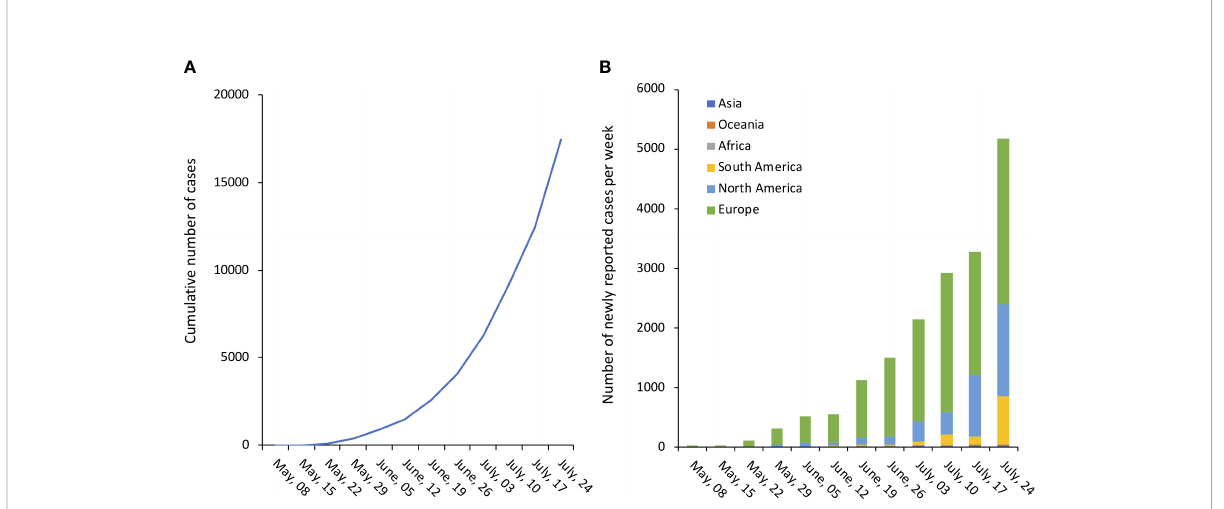
FIGURE 1 Number of con fi rmed monkeypox cases. (A) . Cumulative number of con fi rmed cases worldwide. (B) . Number of newly reported con fi rmed cases per week, by continent/subcontinent. Source of original data https://www.monkeypox.global.health/, accessed on July 25,